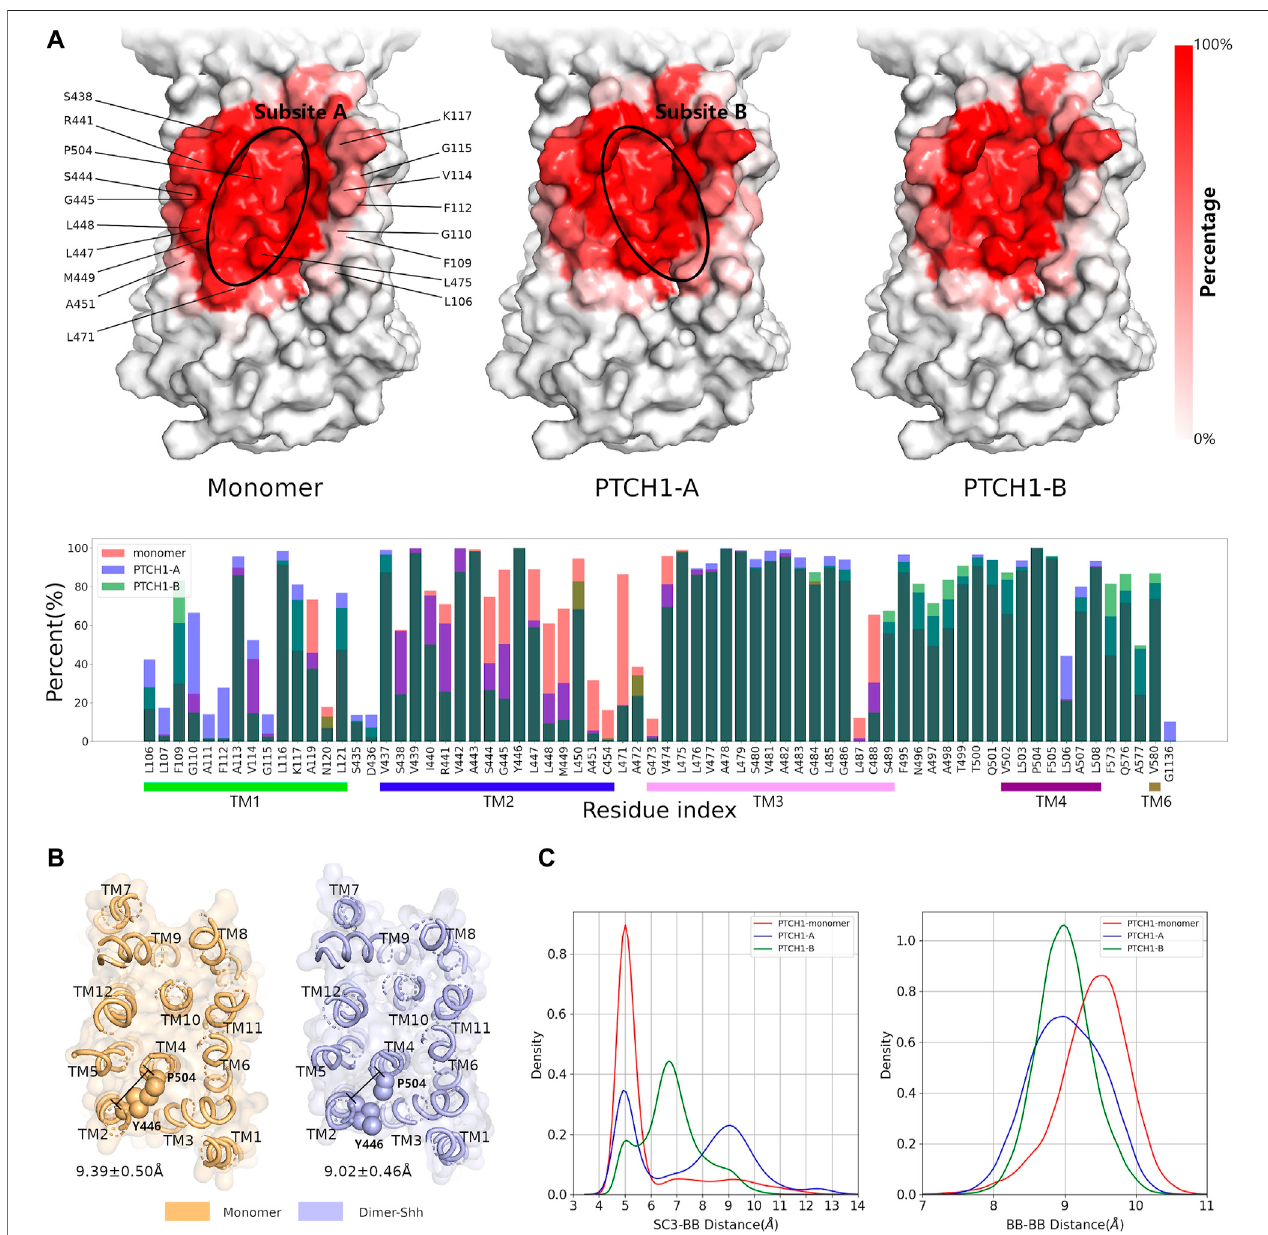
FIGURE 3 | Interactions between CHOL and the SSD. (A) Frequencies of residues in the SSD involved in interacting CHOLs for the monomer and dimer-Shh (PTCH1-AandPTCH1-B) systems.Thedarkerthered,thehigherthefrequency. (B) TheconformationofY446inmonomer anddimer-Shhsystems. (C) Distributionsof distances between sidechains (SC3 bead) of Y446 and the backbone (BB) of P504, and backbones of Y446 and